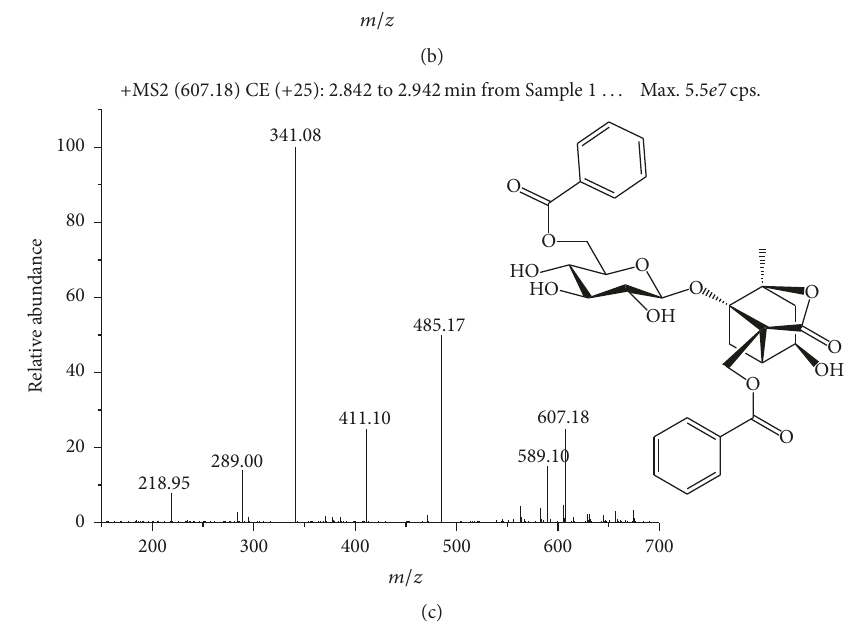
Figure 1: MS/MS spectra and structures of the two analytes and IS: (a) IS, parent ion: m/z 417.38; daughter ion: m/z 296.90; (b) BP, parent ion: m/z 583.18; daughter ion: m/z 165.05; (c) BA, parent ion: m/z 607.18; daughter ion: m/z